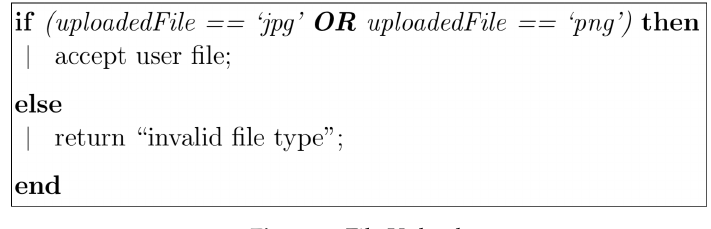
Figure 1. File Upload.